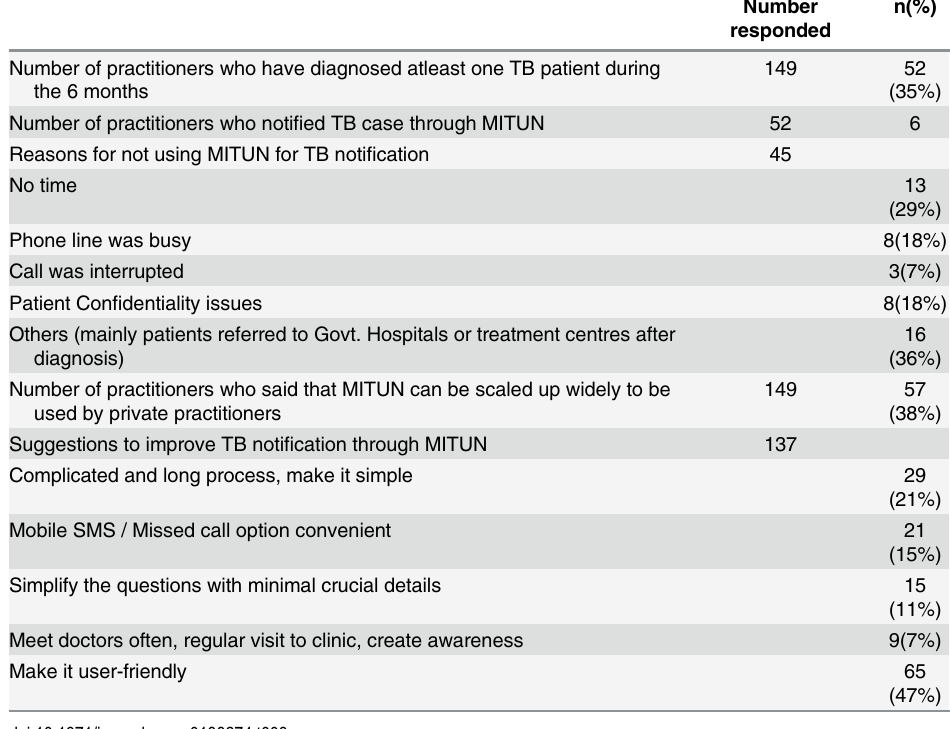
Table 3. The responses of the Private Medical Practitioners for the post-intervention questionnaire regarding feasibility of using MITUN for TB notification.